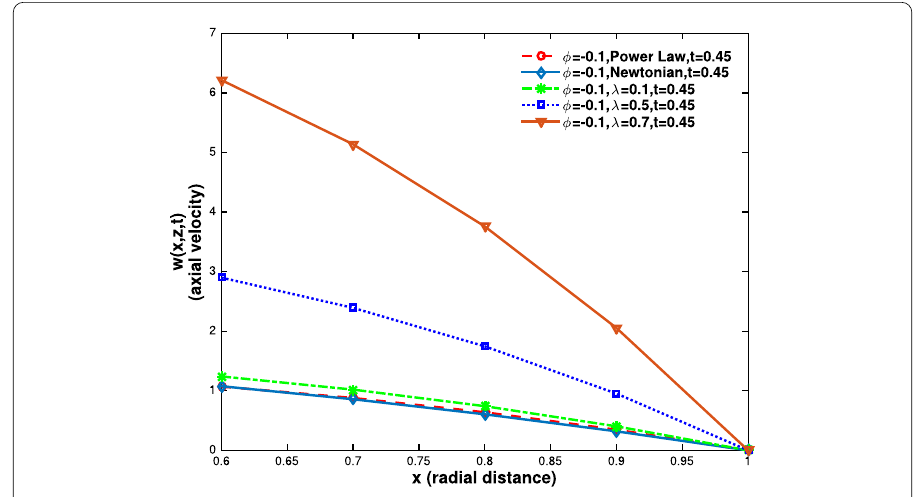
Figure 14 Axial velocity vs radial distances (near wall) for φ = –0.1, λ = 0.1,0.5,0.7 at z = 28, t = 0.45, τ y = 0.4, K = 1.6, Power Law model ( λ → 0) and Newtonian fluid ( λ → 0, ¯ K = 0.035, n = 1)